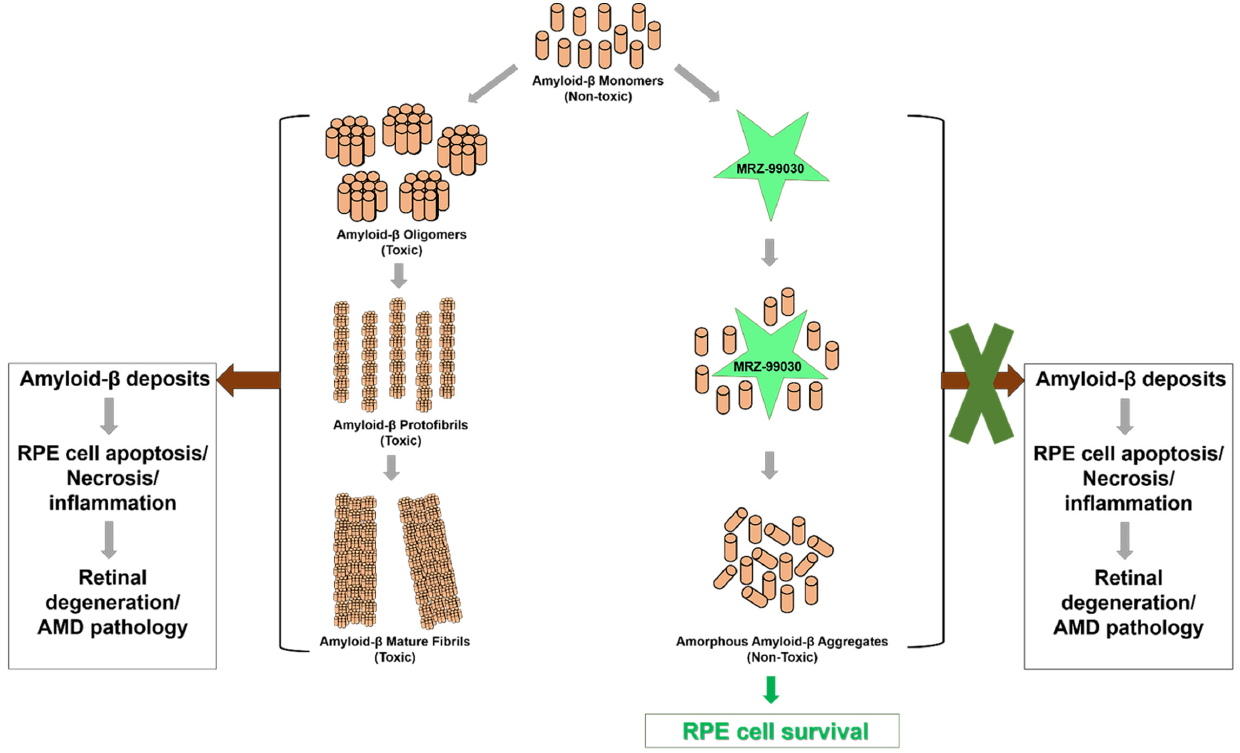
Figure 2. MRZ-99030 ′ s mechanism of action. MRZ-99030 binds to amyloid- β monomers resulting in amorphous, non-toxic amyloid- β aggregates, thereby preventing their assembly into toxic mature amyloid- β fibrils. This in turn blocks the accumulation of amyloid- β deposits and prevents RPE cell degeneration and AMD pathogenesis.